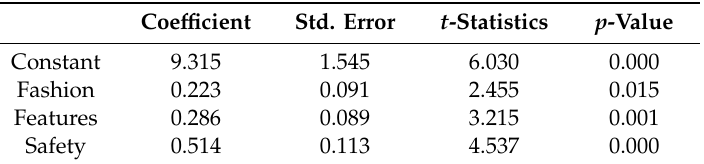
Table 8. Dependent variable economic